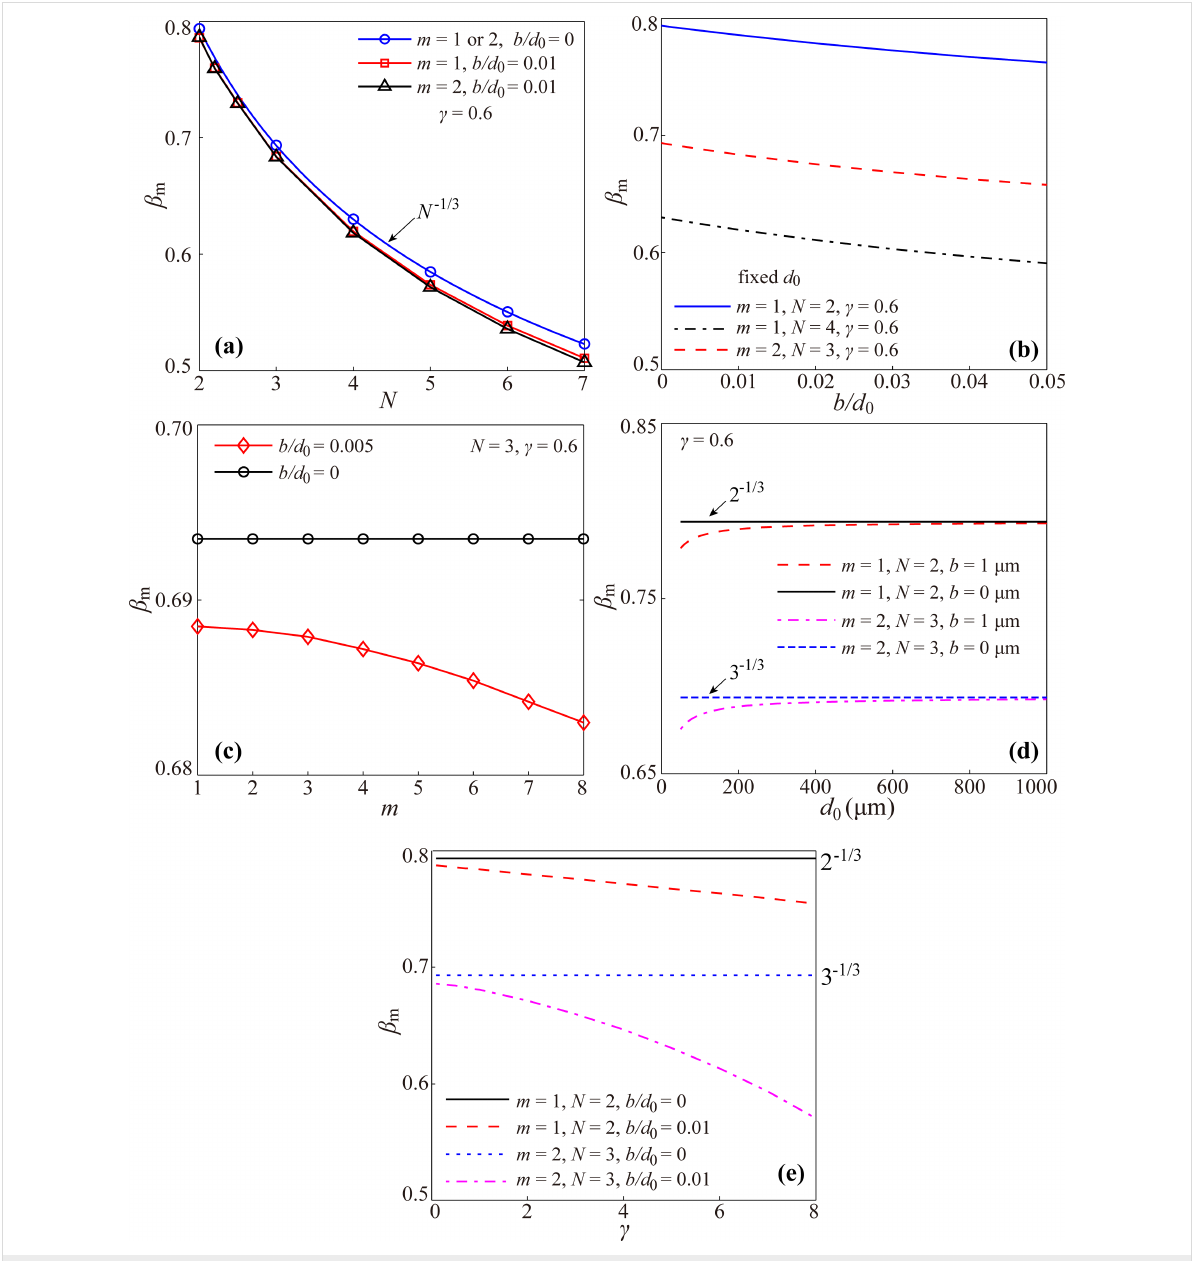
Figure 4: The optimal diameter ratio to achieve minimum hydraulic resistance versus (a) the branching number N , (b) slip length b , (c) the level num- ber m , (d) the channel diameter d 0 at the 0th level and (e) the length ratio γ .